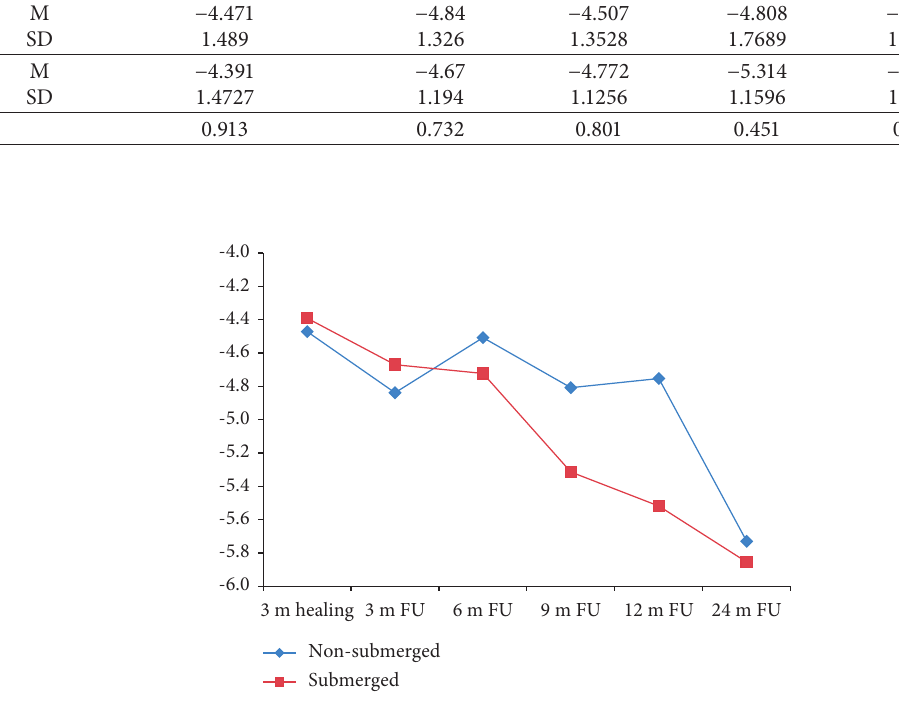
Figure 5: Mean PTV between NS and S in the ball attachment